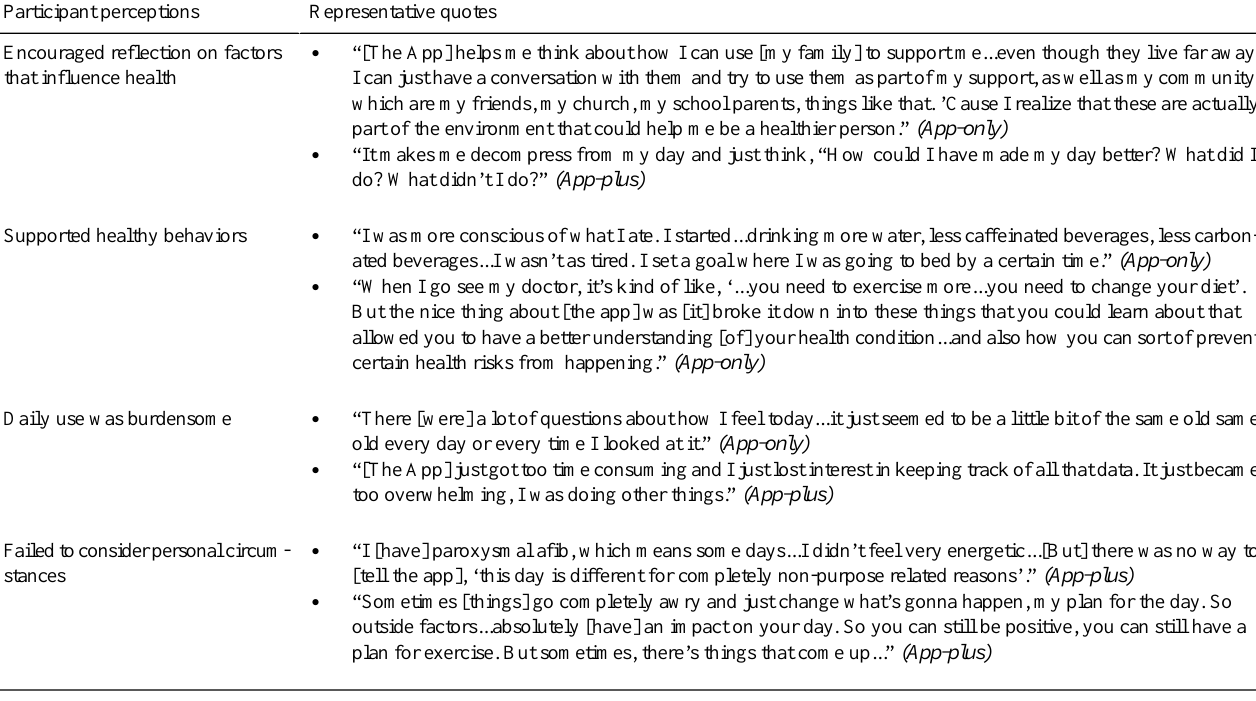
Table 3. Participants’perceptions of the mHealth app and representative quotes.